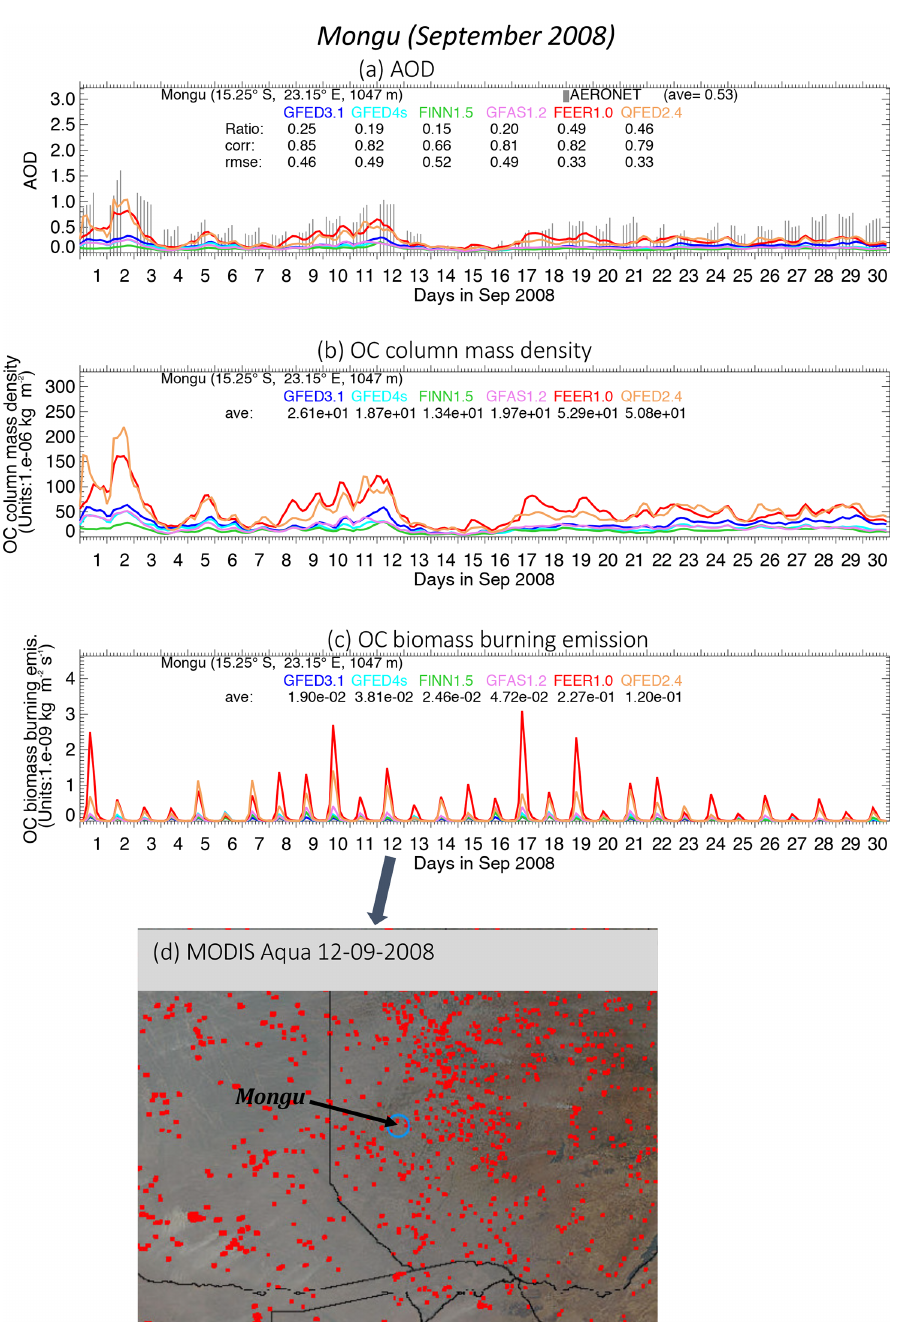
Figure 9. Characteristics of the observed and the simulated aerosols at Mongu during September 2008: (a) the 3-hourly time series of AOD at 550nm. The AERONET AOD is represented by vertical gray bars, and the outputs from the six model experiments are represented by the color curves. The relevant statistics are listed: ave is the monthly average, ratio is the fraction of the simulated to the observed AOD at all observed hours, corr is correlation coefficient between the observed and the simulated AOD, and RMSE is root-mean-square error. (b) The 3-hourly time series of OC column mass density over the grid box where Mongu is located (units: 1 × 10 − 6 kgm − 2 or mgm − 2 ). (c) Same as panel (b) but for biomass burning OC emission rate (units: 1 × 10 − 9 kgm − 2 s − 1 or µgm − 2 s − 1 ). (d) MODIS Aqua true-color image around Mongu on 12 September 2008, overlaid with the active fire detections as red dots (image credit: https://aeronet.gsfc.nasa.gov/cgi-bin/ bamgomas_interactive and